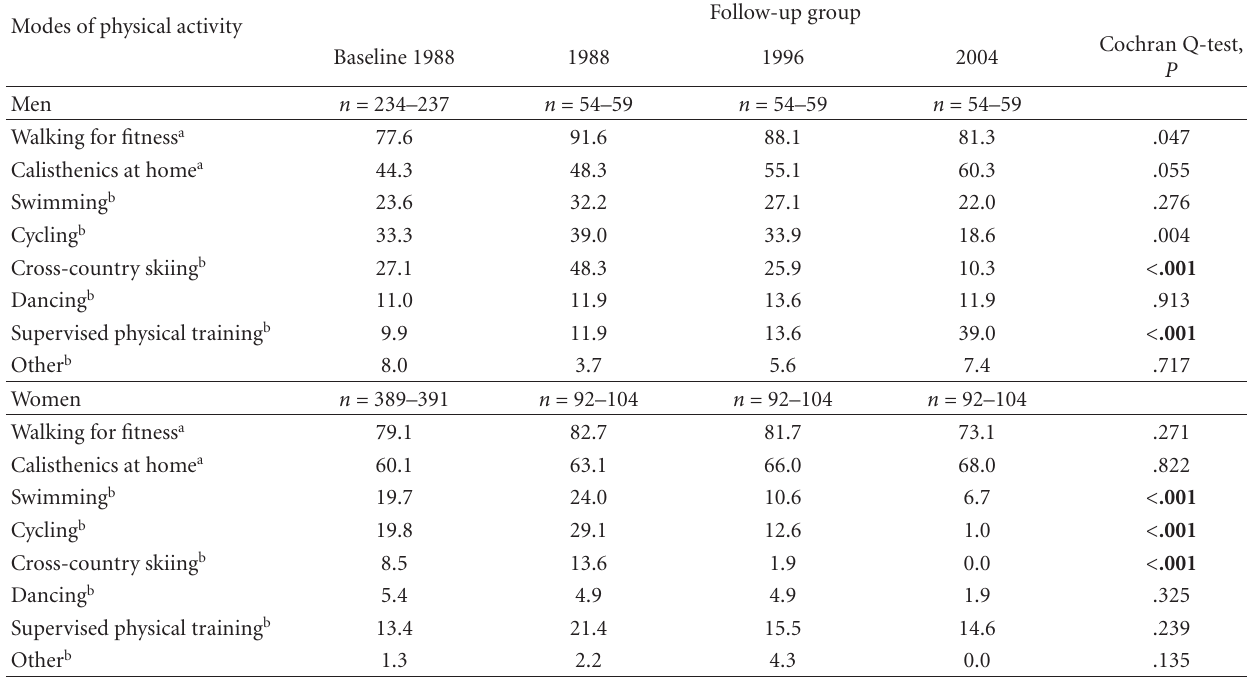
Table 2: Modes of physical activity among men and women born in 1914–1923 aged 65–74 years at baseline and the group followed over 16 years (%, P ).